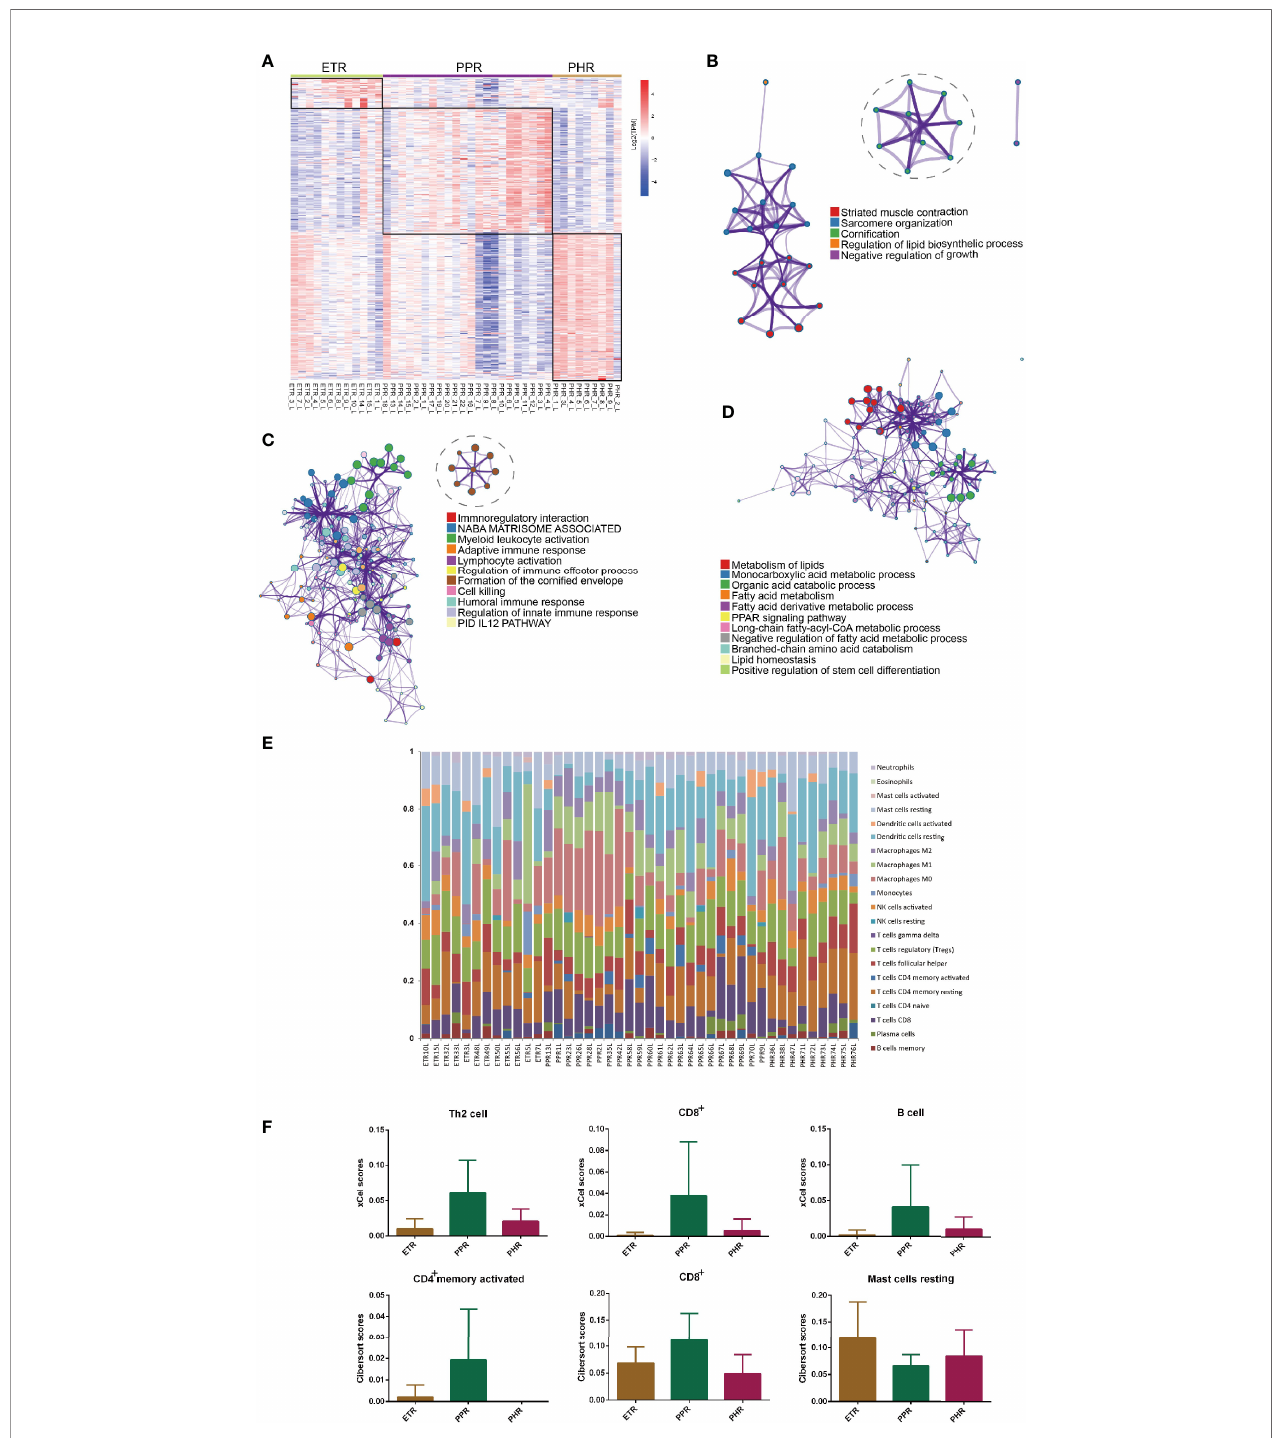
FIGURE 6 | Subtype-speci fi c gene signatures and immune cells across ETR, PPR and PHR subtypes. (A) Heatmap of the different upregulated genes among the subtypes. (B) Metascape network analysis of enrichment for upregulated genes in ETR subtype. (C) Metascape network analysis of enrichment for upregulated genes in PPR subtype. (D) Metascape network analysis of enrichment for upregulated genes in PHR subtype. (E) The composition of 22 immune cells for each sample across ETR, PPR and PHR subtypes by CIBERSORT algorithm. (F) Difference in number of immune cells among ETR, PPR and PHR subtypes. The xCell algorithm identi fi ed immune cells including T helper 2 cells, CD8 + T cells and B cells, and the CIBERSORT algorithm revealed the different abundance of resting mast cells, and activated CD4 + memory and CD8 + cells among ETR, PPR and PHR